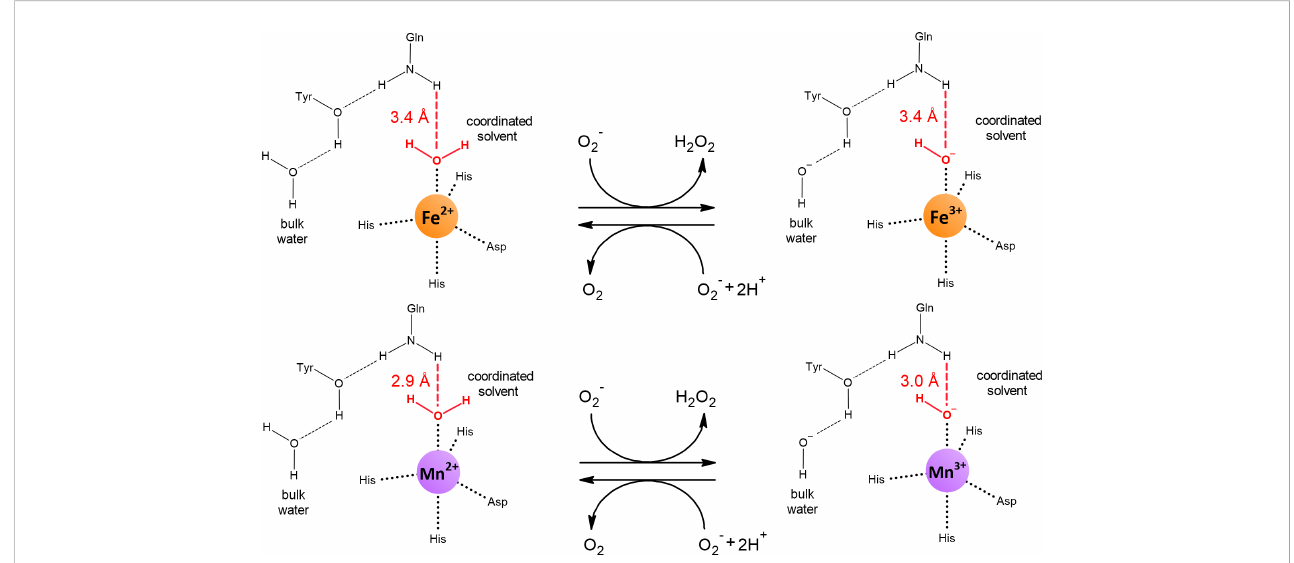
FIGURE 5 Reduced and oxidized states of Fe-SOD and Mn-SOD. Dashed lines represent hydrogen bonds. The amide group of the side chain of the conserved glutamine is a hydrogen bond donor for the coordinated solvent (in red). The shorter the hydrogen bond, the more the redox potential of the bound metal decreases. The distances were obtained from the crystal structures of E. coli Fe 2+ -SOD (PDB: 1ISA), Fe 3+ -SOD (PDB: 1ISB), Mn 2+ -SOD (PDB: 1IX9) and Mn 3+ -SOD (PDB: